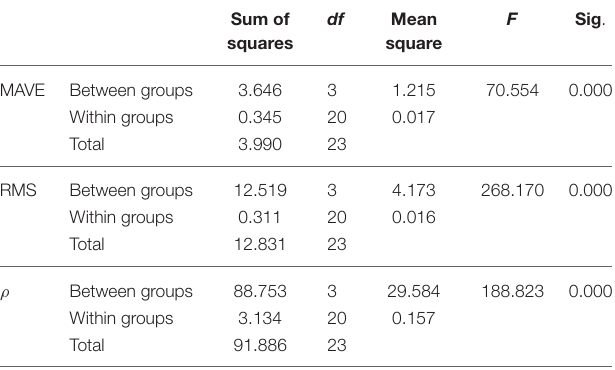
TABLE 5 | The results of the One-way ANOVA.